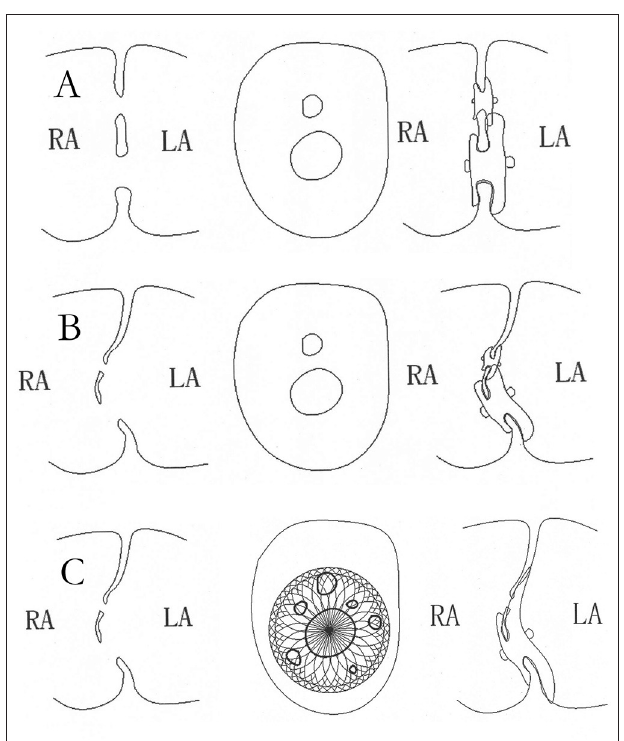
FIGURE 3 | The schematic diagram of closure with standard ASDO in multiple ASDs. The double device in multiple ASDs (A) or with ASA (B) , the schematic diagram of closure with small-waist–big-edge ASDO in multiple ASDs with ASA (C) . ASD, atrial septal defect; ASDO, atrial septal defect occluder; ASA, atrial septal